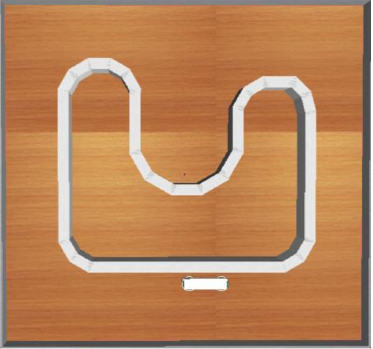
Figure 13. Cooperative load-carrying wall-following control.